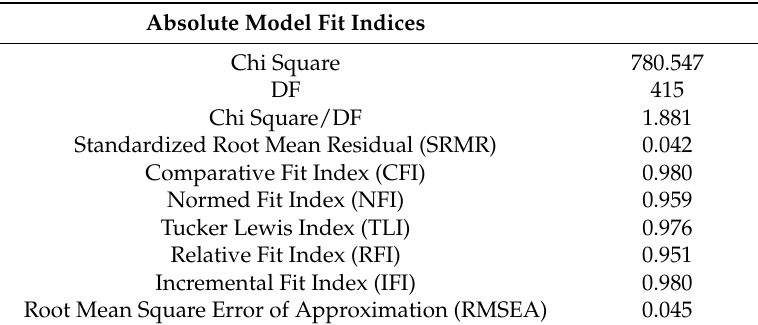
Table 6. Model fit